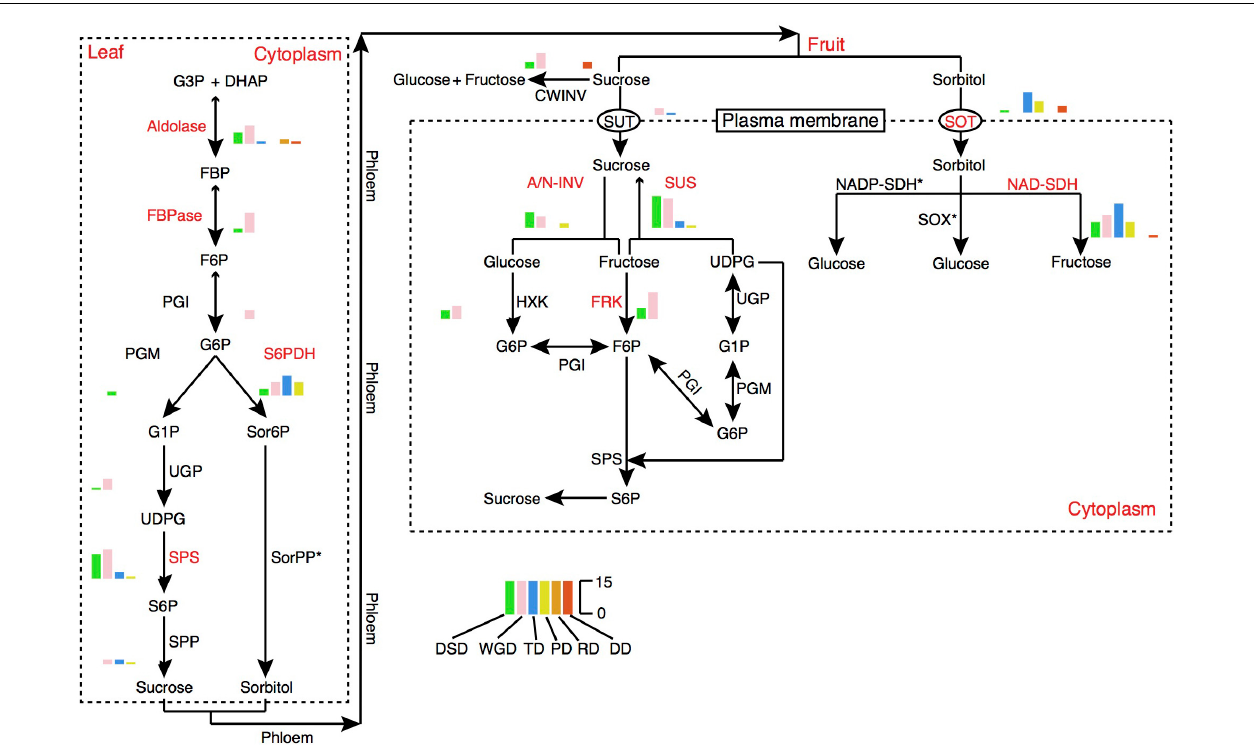
FIGURE 7 | The expansion pattern of gene families involved in sugar metabolism pathways. The expanded gene families are marked in red color. The histogram indicates the numbers of different modes of duplicated genes. A/N-INV, alkaline/neutral invertase; CWINV, cell-wall invertase; DHAP, dihydroxyacetone phosphate; FBP, fructose 1,6-bisphosphate; FBPase, fructose-1,6-bisphosphatase; F6P, fructose 6-phosphate; FRK, fructokinase; G1P, glucose 1-phosphate; G3P, Glyceraldehyde 3-phosphate; G6P, Glucose 6-phosphate; HXK, hexokinase; NAD-SDH, NAD-sorbitol dehydrogenase; NADP-SDH, NADP-sorbitol dehydrogenase; PGI, phosphoglucose isomerase; PGM, phosphoglucomutase; Sor6P, sorbitol 6-phosphate; SorPP, sorbitol-6-phosphate phosphatase; S6P, sucrose 6-phosphate; S6PDH, sorbitol 6-phosphate dehydrogenase; SOT, sorbitol transporter; SPP, sucrose phosphate phosphatase; SPS, sucrose phosphate synthase; SUS, sucrose synthase; SUT, sucrose transporter; SOX, sorbitol oxidase; UDPG, UDP-glucose; UGP, UDP-glucose